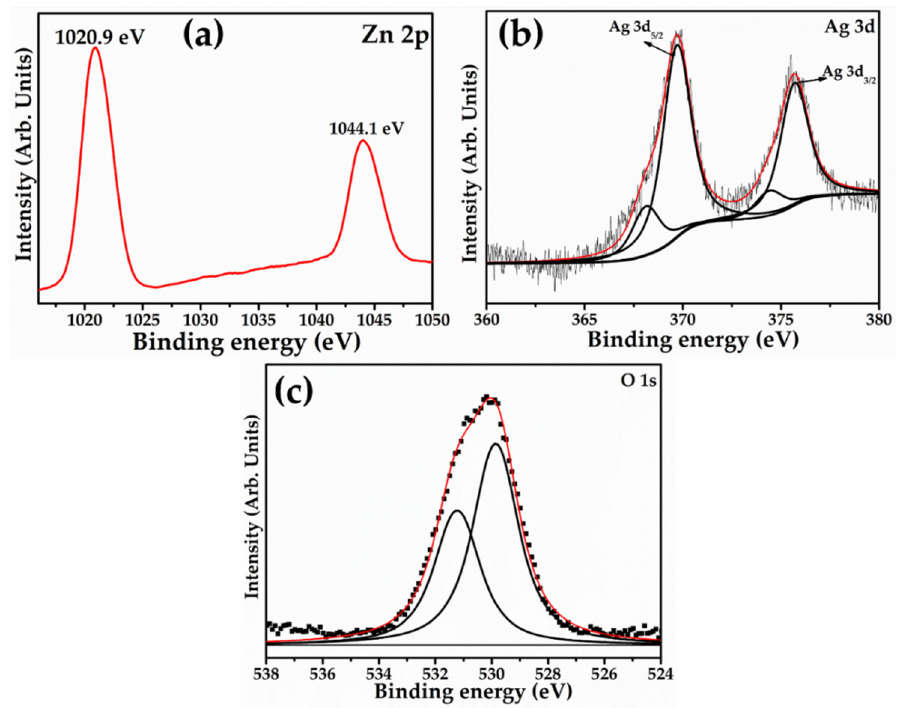
Figure 5. Typical XPS spectra of ( a ) Zn 2p, ( b ) Ag 3d, and ( c ) O 1s of synthesized Ag-doped ZnO nanoflowers decorated with nanosheets.